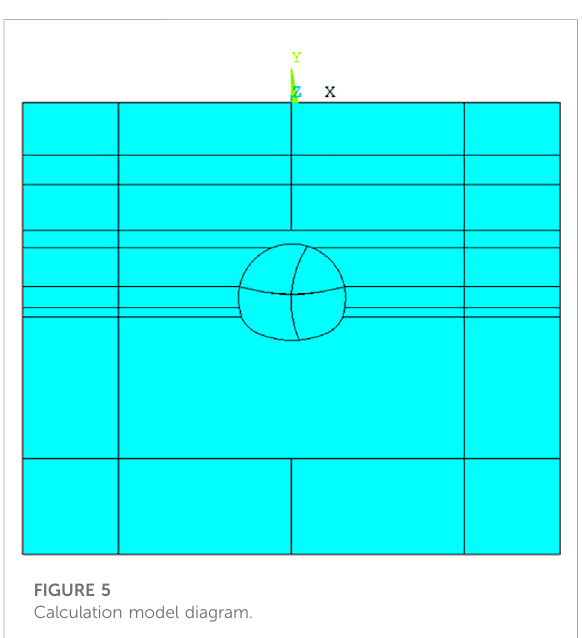
FIGURE 5 Calculation model diagram.